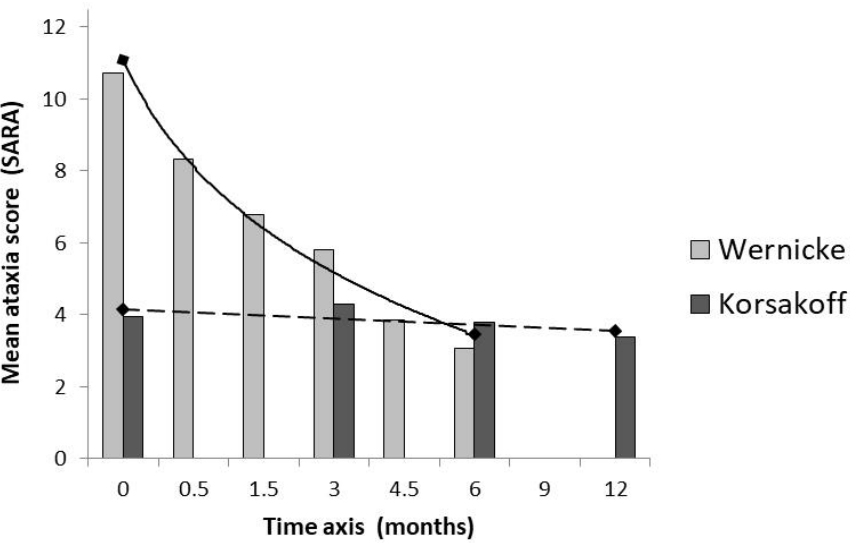
Figure 2. Mental and motor symptoms in Wernicke-Korsakoff syndrome. A patient’s mobility and evolving neuropsychiatric symptoms in Wernicke-Korsakoff syndrome (dashed line), starting with initial hospitalization at 0 months. Arrows depict alternative outcomes: further decline, full recov- ery, or protracted delirium.